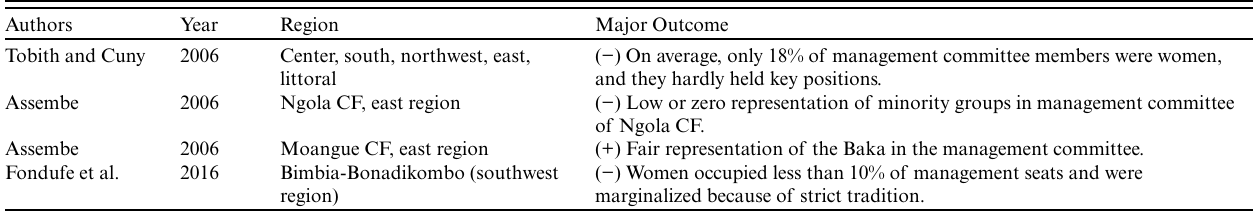
Table 7 . Community forest (CF) representation in Cameroon. Authors Center, south, northwest, east, littoral Ngola CF, east region Assembe 2006 Moangue CF, east region 2016 Bimbia-Bonadikombo (southwest